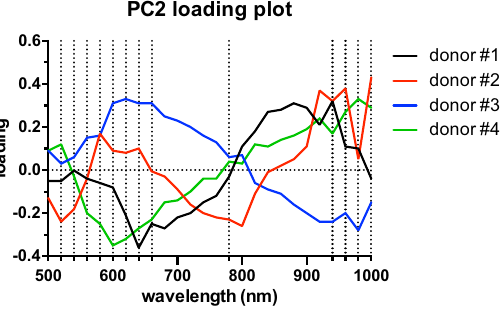
Figure 6. PC2 loading plot. Loading plot for the second principal component (PC2), along which the M1/M2 separation occurred. Wavelengths chosen for LDA analysis are marked by dotted lines.